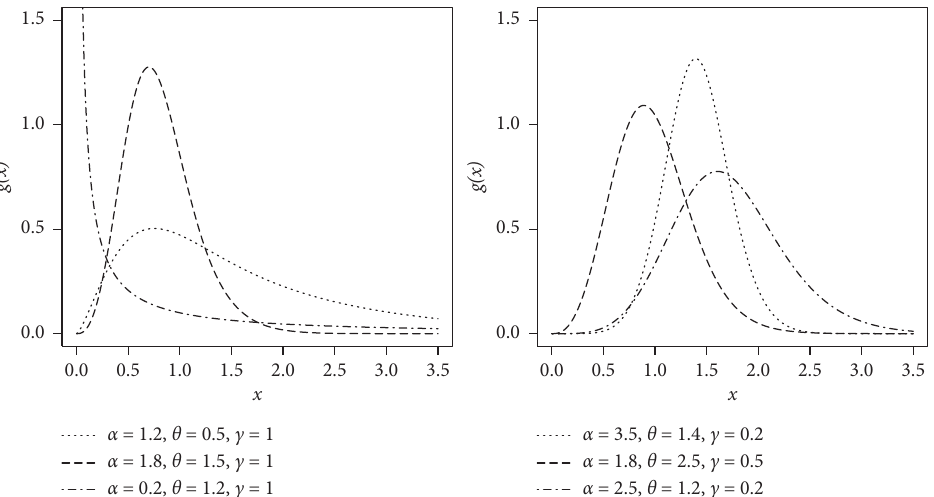
Figure 1: Density plots of the NGE-Weibull distribution.